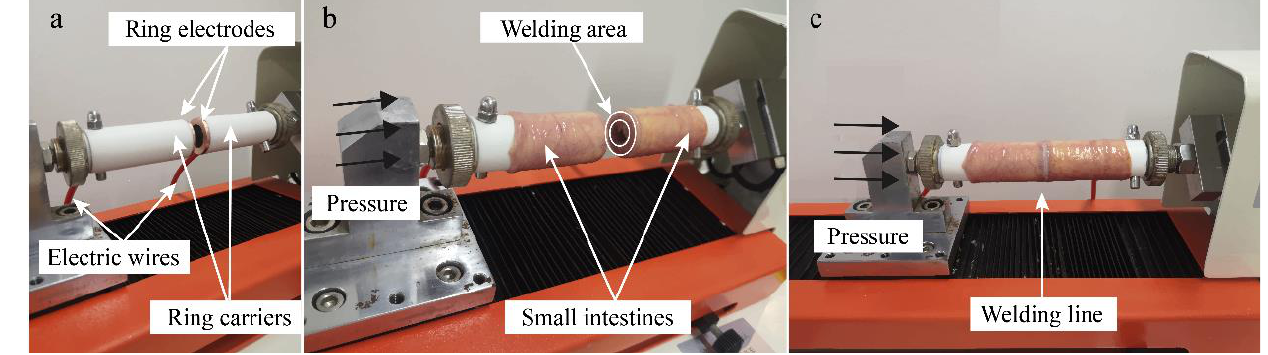
Figure 2. ( a ) Self-designed copper ring electrodes. The pair of self-designed copper ring electrodes has an inner diameter d of 13.31 mm and an outer diameter D of 23.09 mm. The electrodes are fixed onto the ring carriers of the horizontal tensile testing machine. ( b ) Small intestine welding area. Two sections of the small intestines are sleeved outside the ring carriers apart, and the welding area is the ring part of the small intestine covering the electrodes. ( c ) Welded intestines under pressure application. The serosal layers would be butted tightly under the set compression pressure, and the welding line would appear somewhat white after welding because of protein thermal denaturation.